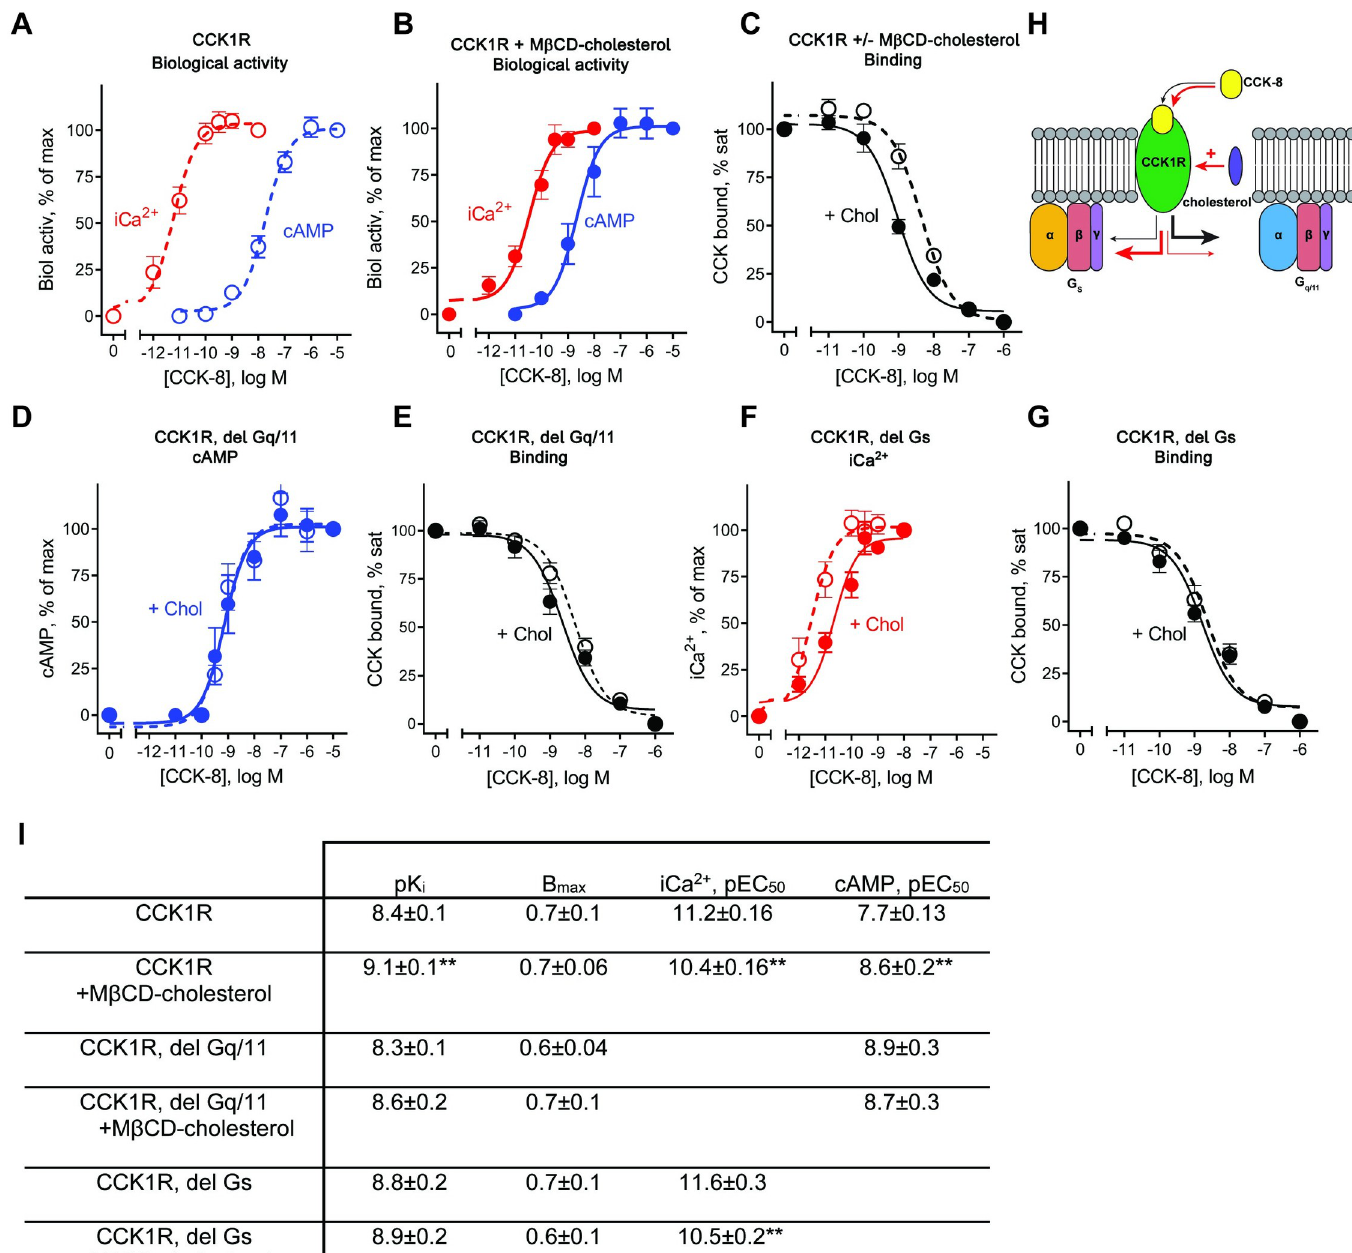
Fig 1. Effects of G protein association and cellular cholesterol on CCK-8 binding and biological activity. Shown are data for stable CCK1R-expressing HEK293s cell lines for parental cells or with deletion of Gq/11 or Gs proteins, in the absence or presence of increased cellular cholesterol by treatment with M β CD–cholesterol complex. Receptor density was not different between the cell lines. ( A ) In untreated cells, CCK was much more potent in stimulating iCa 2+ mobilisation than cAMP production. ( B ) After enhancing cellular cholesterol, CCK-8 potency in the iCa 2+ mobilisation assay was reduced, but potency for cAMP production was increased. ( C ) Increased cellular cholesterol resulted in an increase in CCK-8 binding affinity. ( D ) In the cell line in which Gq/11 proteins were deleted, CCK-8 potency in the cAMP assay to CCK was increased and was not affected by cholesterol enhancement, whereas ( E ) CCK-8 binding affinity was not significantly different. ( F ) In the cell line in which Gs protein was deleted, CCK-8 potency in the iCa 2+ assay and sensitivity to increasing cellular cholesterol were equivalent to parental cells, whereas ( G ) CCK-8 binding affinity was insensitive to altered cholesterol. ( H ) Schematic of CCK1R signalling. Under conditions of normal membrane cholesterol, CCK-8 signals predominantly via Gq/11 proteins with weak activation of Gs protein. With high cholesterol, there is increased Gs-mediated and decreased Gq/11-mediated signalling. ( I ) Quantitative pharmacology analysis of the data in panels A–G. Values are mean ± SEM from 6 to 8 independent experiments performed in duplicate. �� P < 0.01; significant differences were determined using a Mann–Whitney test for treated cells versus cells without MßCD–cholesterol treatment. Data files for graphs are provided as S1 Data. CCK, cholecystokinin; CCK1R, cholecystokinin type 1 receptor; iCa 2+ , intracellular Ca 2+ ; M β CD, methyl- β -cyclodextrin.